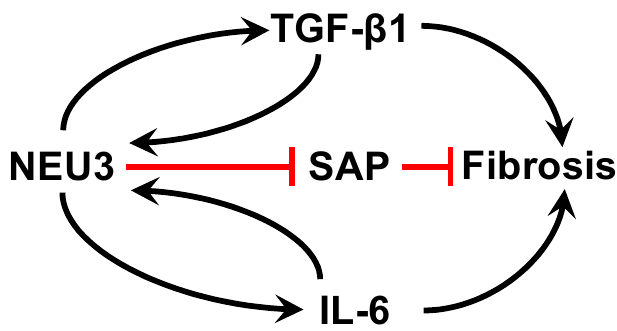
Figure 1. Summary of pathways used by NEU3 to potentiate fibrosis.